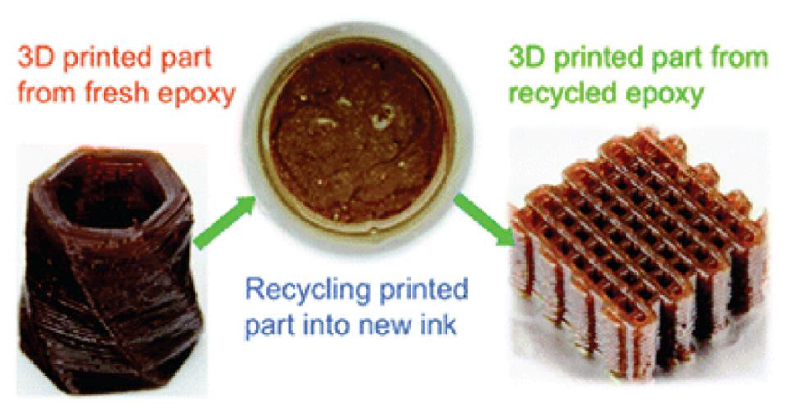
Figure 5. High temperature and recycled 3D thermoset polymeric